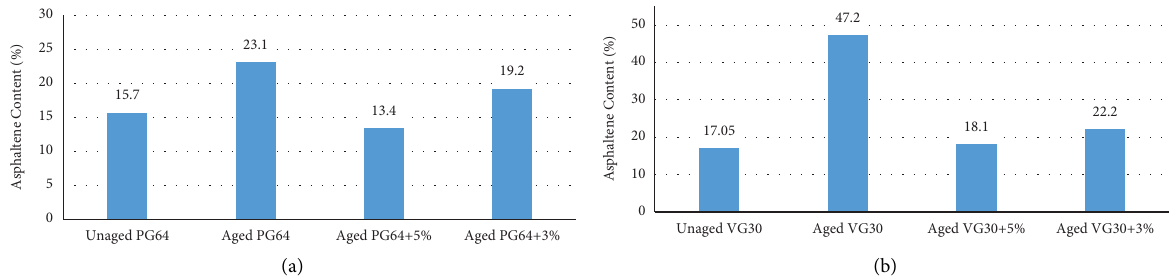
Figure 9: Variation in asphaltene content in diferent bitumens: (a) PG 64-10; (b) VG30.